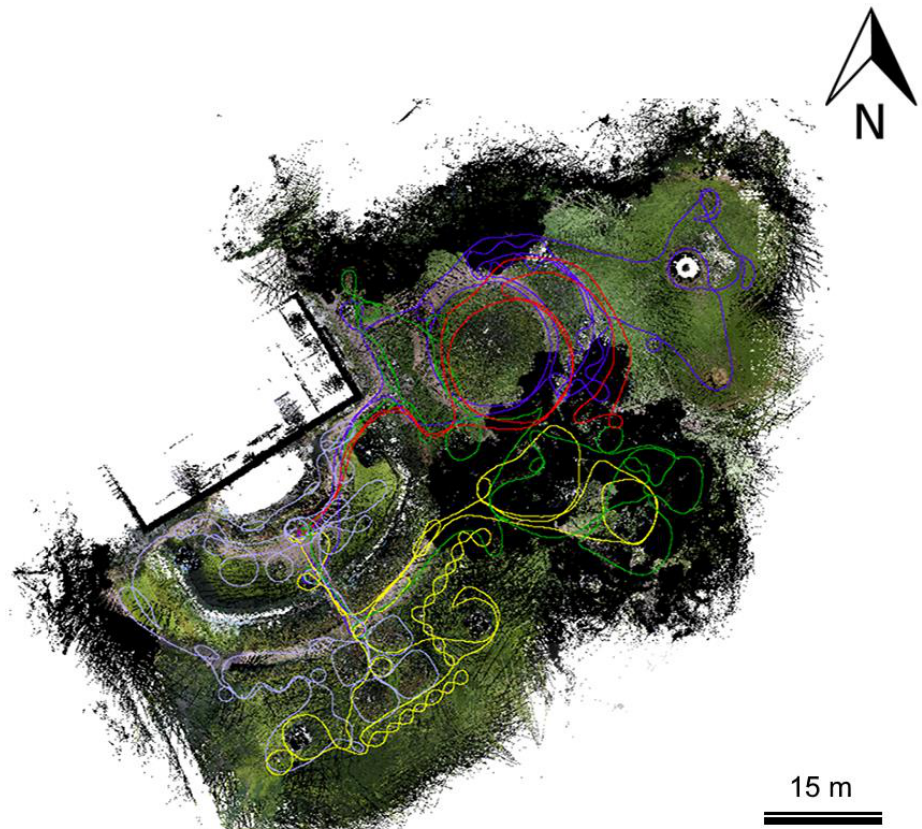
Figure 4. GeoSLAM ZEB Revo RT point cloud with independent measurement trajectories which are colored individually as blue, red, yellow, green, and purple. The point cloud is colored with the data of the integrated camera system, and the black points are laser scanning points that do not have any color value from camera data.